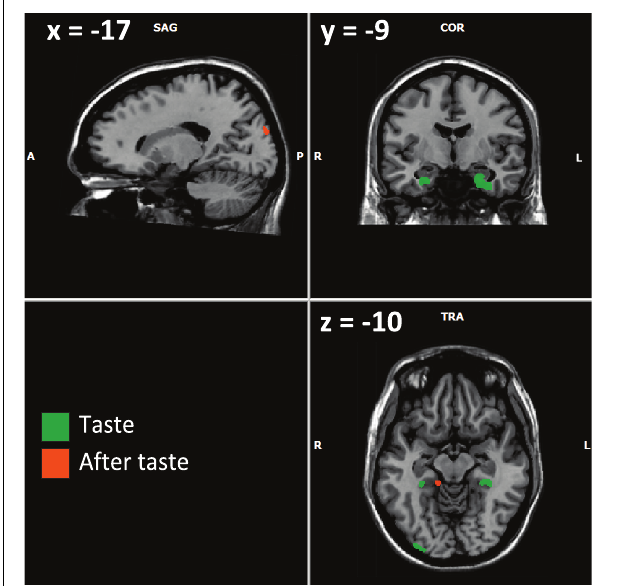
FIGURE 3 | Example of activations involving memory (from Table 3) for the contrast experts minus controls. Activations in green are obtained during the taste phase; those in orange are obtained during the after-taste phase. Visible activations are both in the amygdala/hippocampus complex (taste phase), parahippocampal gyri (right and left for the taste phase, right for the after-taste phase), occipital associative cortex (right during the taste phase, left during the after-taste